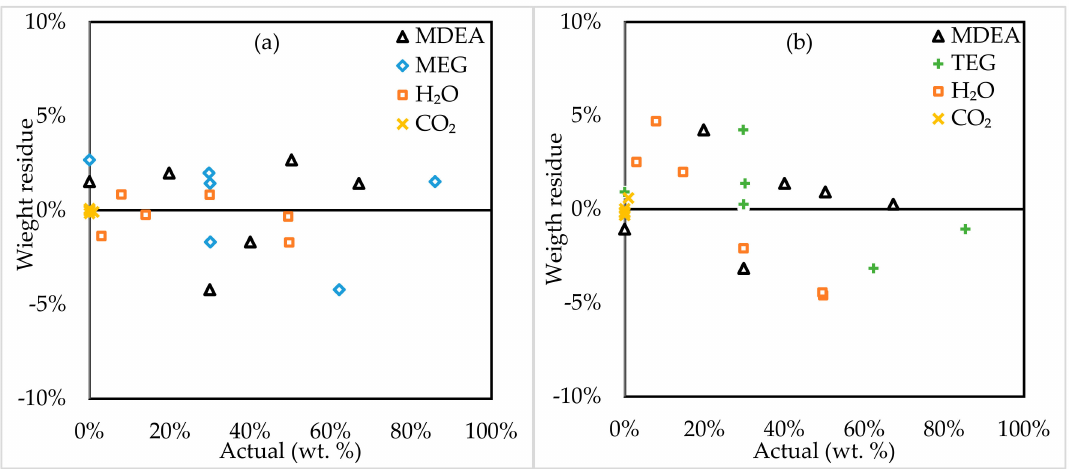
Figure 10. Weight residual of left-out spectra; the MDEA-MEG-H 2 O-CO 2 system ( a ) and MDEA-TEG-H 2 O-CO 2 system ( b